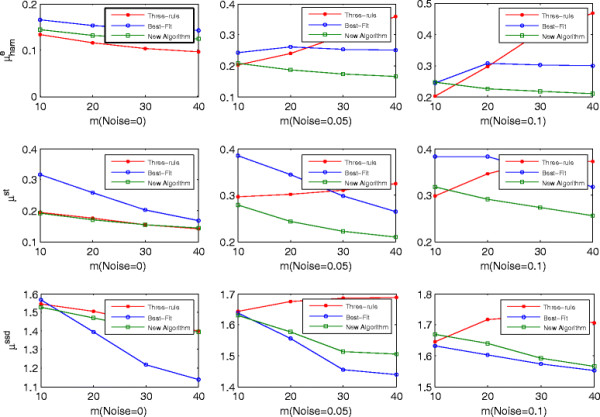
Comparison ofμhame,μhamst,
μ

ssd
for the three algorithms with 0%, 5%, and 10%noises (
K
 
= 5).